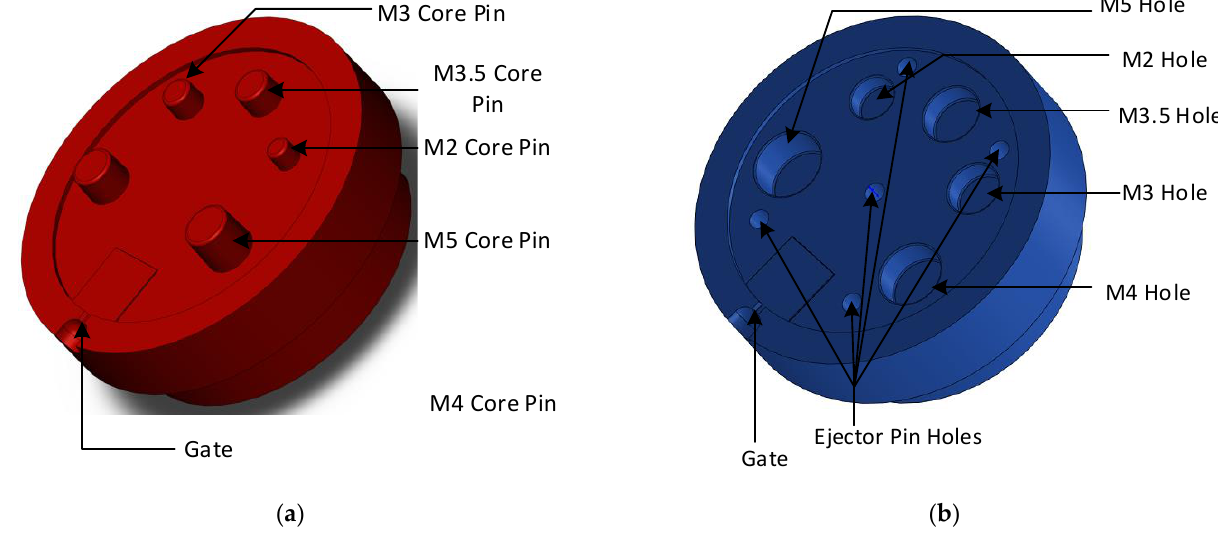
Figure 3. ( a ) Core side of 3DIM showing the raised features (core pins); ( b ) Cavity side of 3DIM showing the core holes and ejector pins. Table 1. Dimensions of the core pin and distance from the gate (extracted and reproduced from Bagalkot et al. (2017) with permission [29]).